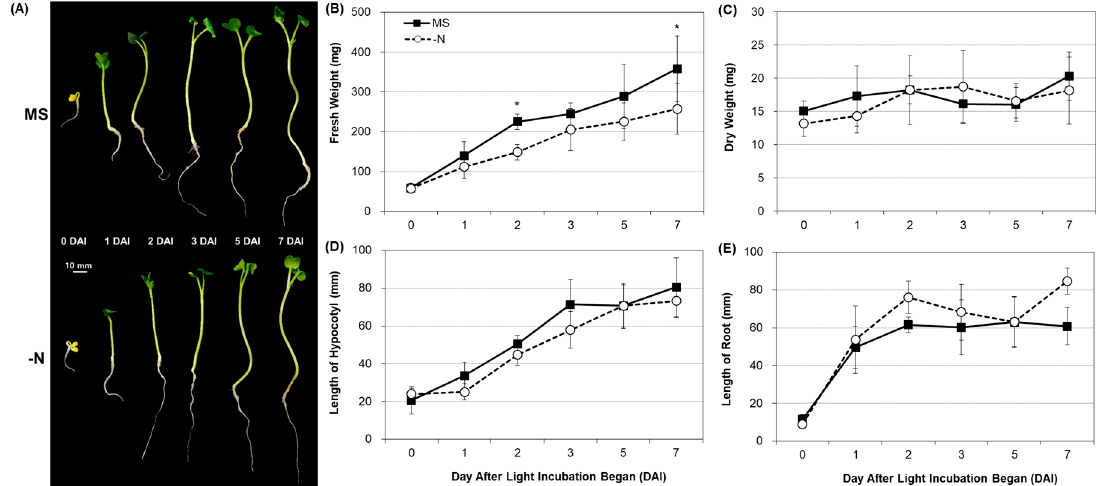
Figure 1. Phenotypic changes in radish sprouts during nitrogen deficient condition. ( A ) Growth of radish sprouts under nitrogen sufficient (MS) and deficient (–N) conditions. ( B ) Fresh weight and ( C ) dry weight of radish sprouts grown under MS and –N conditions. Changes in the length of hypocotyl ( D ) and root ( E ) of radish sprout grown under the two nitrogen conditions. Data for different points are the means ± SD (n = 6). * p ≤ 0.05. DAI, day after light incubation began.